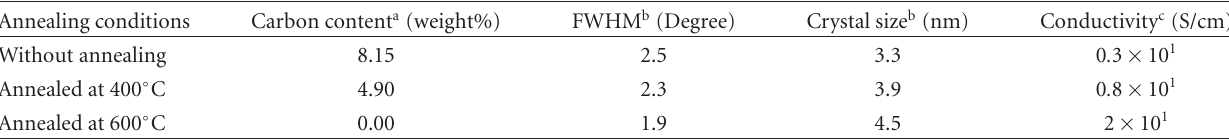
Table 1: Main characteristics of the prepared ITO thin